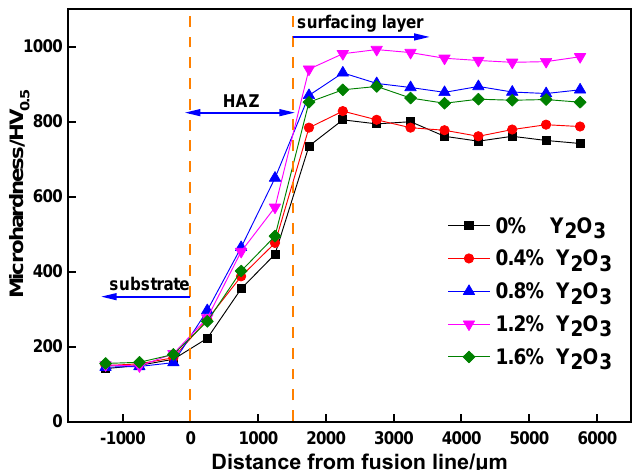
Figure 11. Microhardness of surfacing layer with different Y 2 O 3 content.